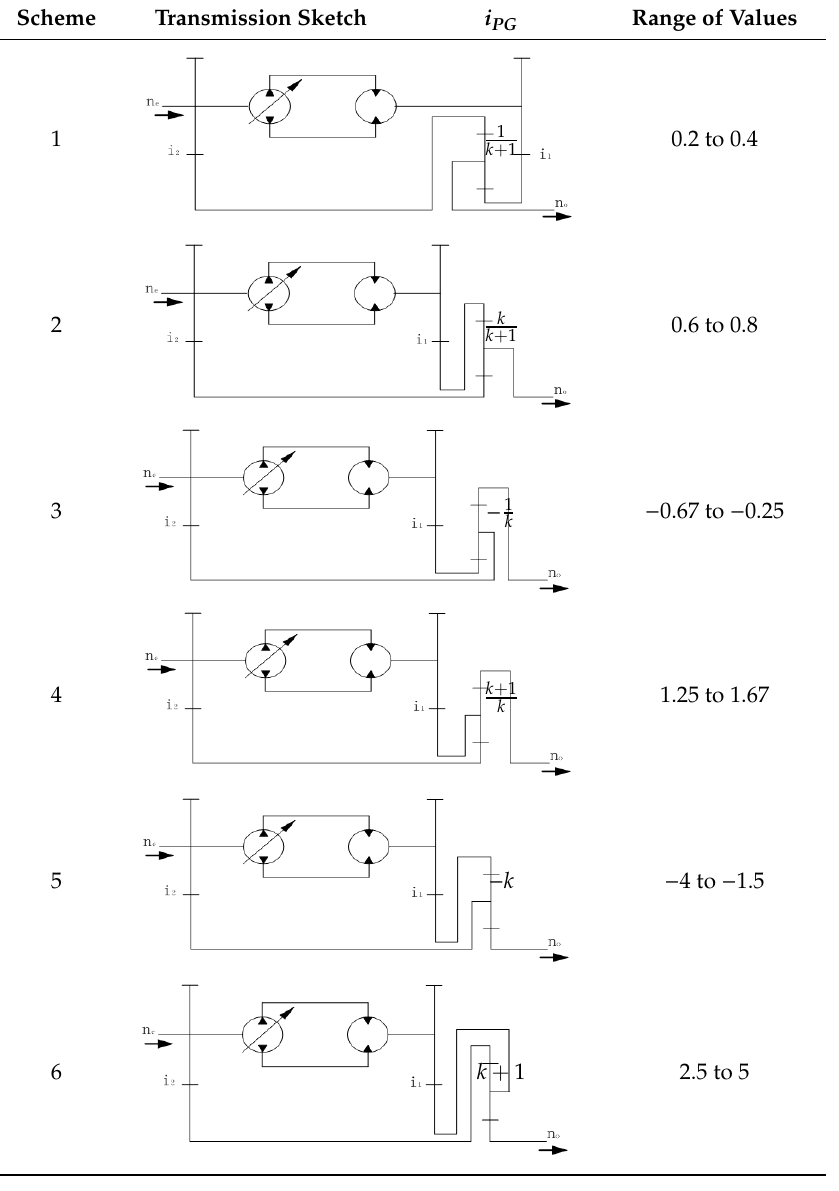
Table 1. The PG transmission sketches of HMCVT.